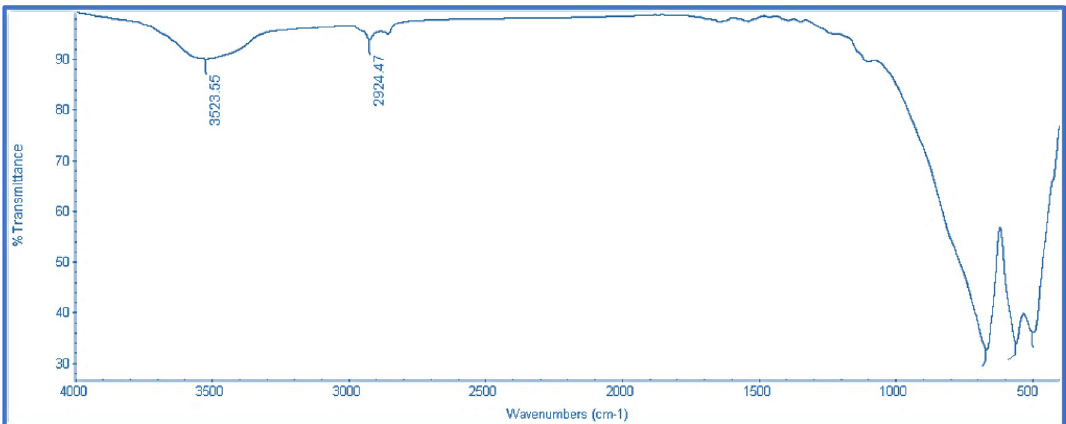
Figure 9. FT-IR of Prepared CoAl 2 O 4